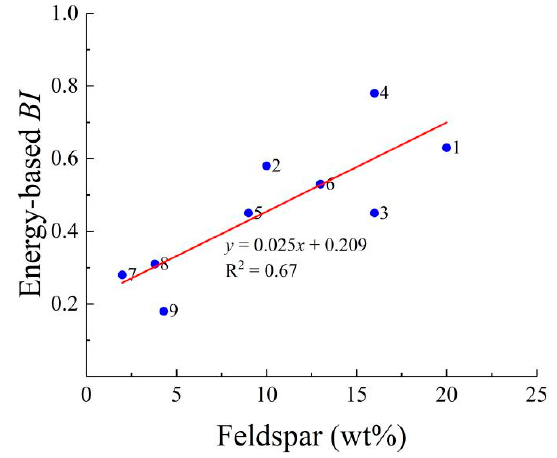
Figure 14. The relationship between energy-based BI and feldspar content.